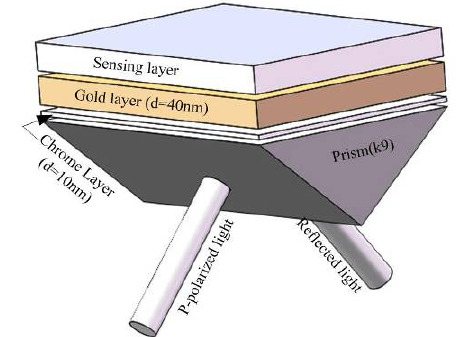
Fig. 1 SPR sensor based on the Kretschmann